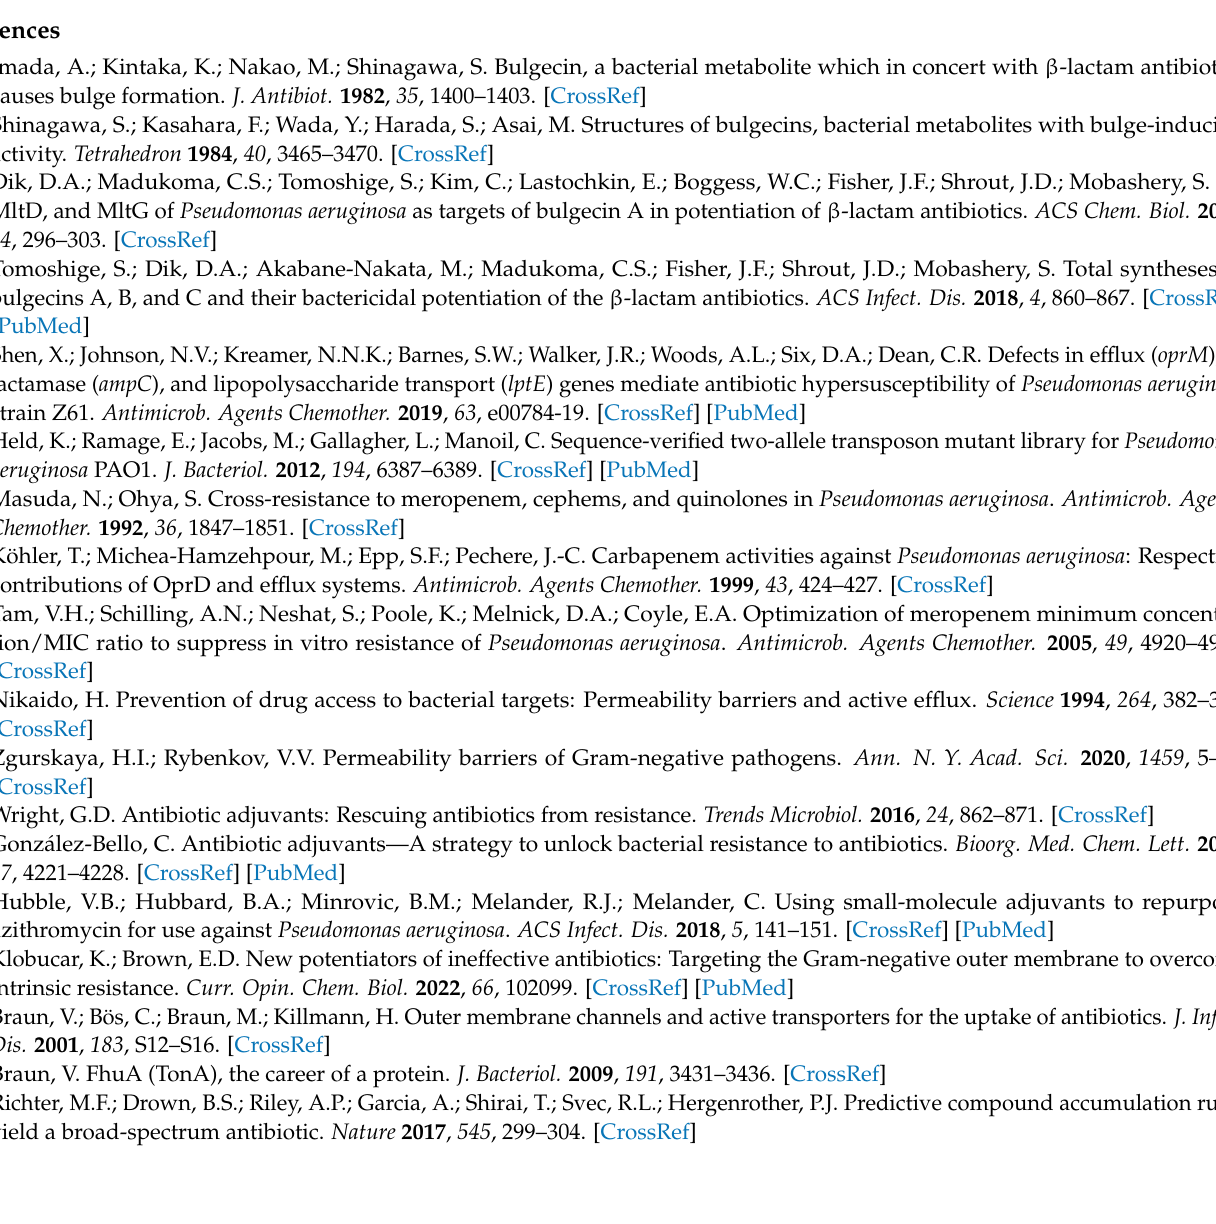
Figure A1. Representative LC/MS traces of bulgecin A and ciprofloxacin. The extracted-ion-chromatograms (EIC)s ( A , C ) and corresponding mass spectra ( B , D ) are given. For mass spectra, top panels show mass spectra of samples and bottoms are theoretical ones.